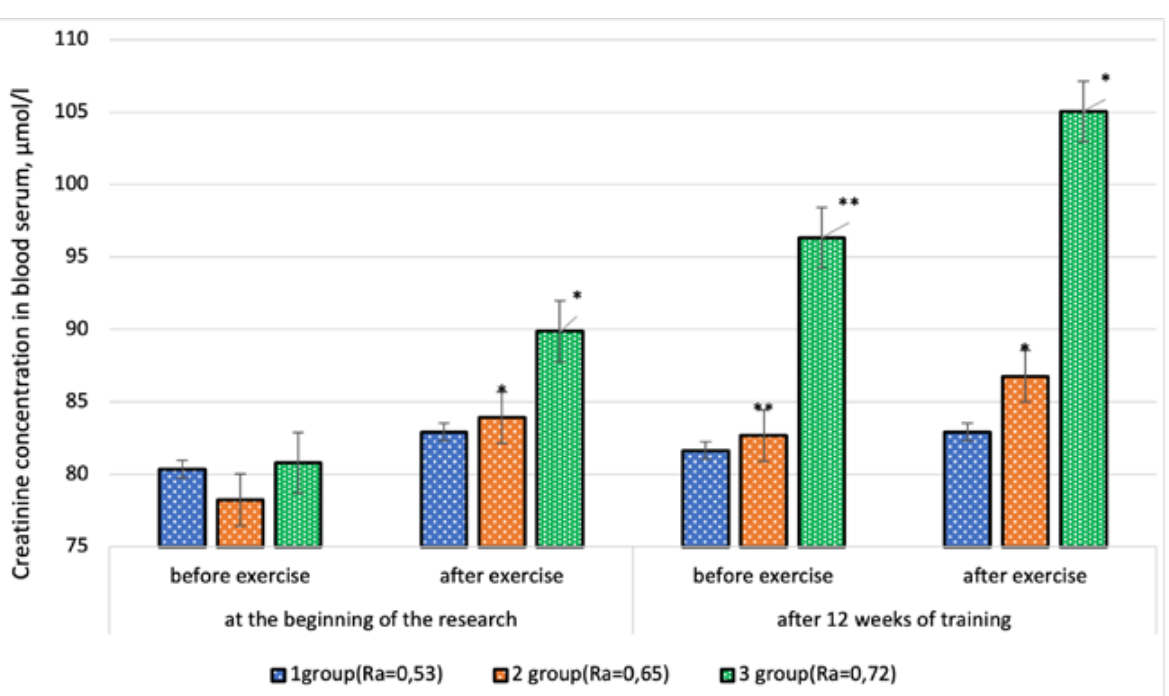
Figure 1. Changes in creatinine concentration in the blood serum of study participants during 12 weeks of training in the conditions of different intensity power load regimes, n=75 Note: * – p<0.05, compared to the indicators before the load; ** – p<0.05, compared to the indicators before the